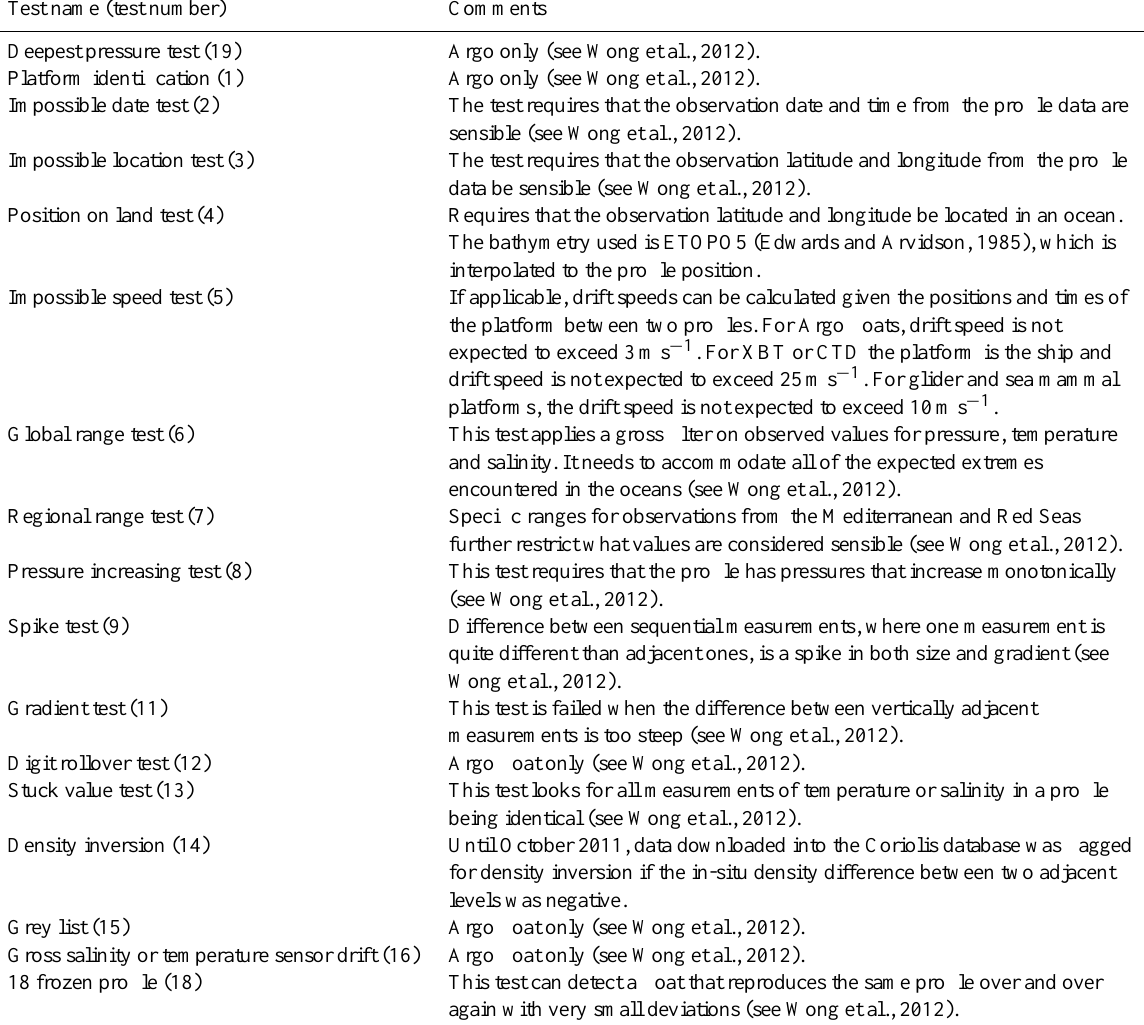
Table 3. Automatic tests applied (in the order given) to the profiles downloaded into the Coriolis database. Unless stated otherwise, one could refer to the Argo Quality Control Manual V2.7 (Wong et al., 2012) for a complete description of these tests. Some of the automatic tests are only specific to Argo floats (e.g. digit rollover test) and are not applied to the other data